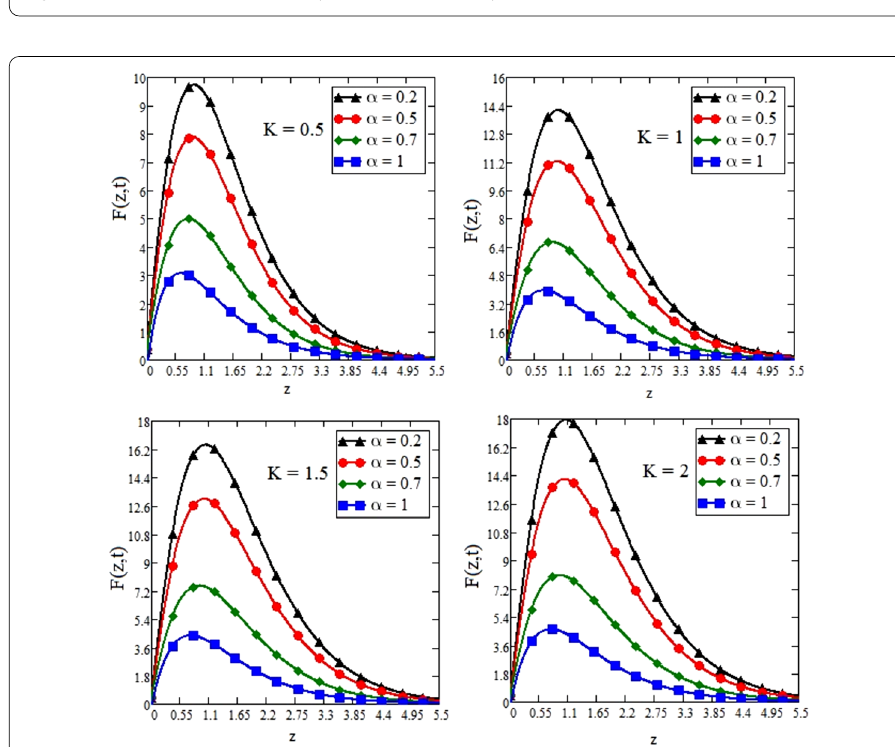
Figure 7 Impact of K on the velocity distribution of Jeffrey